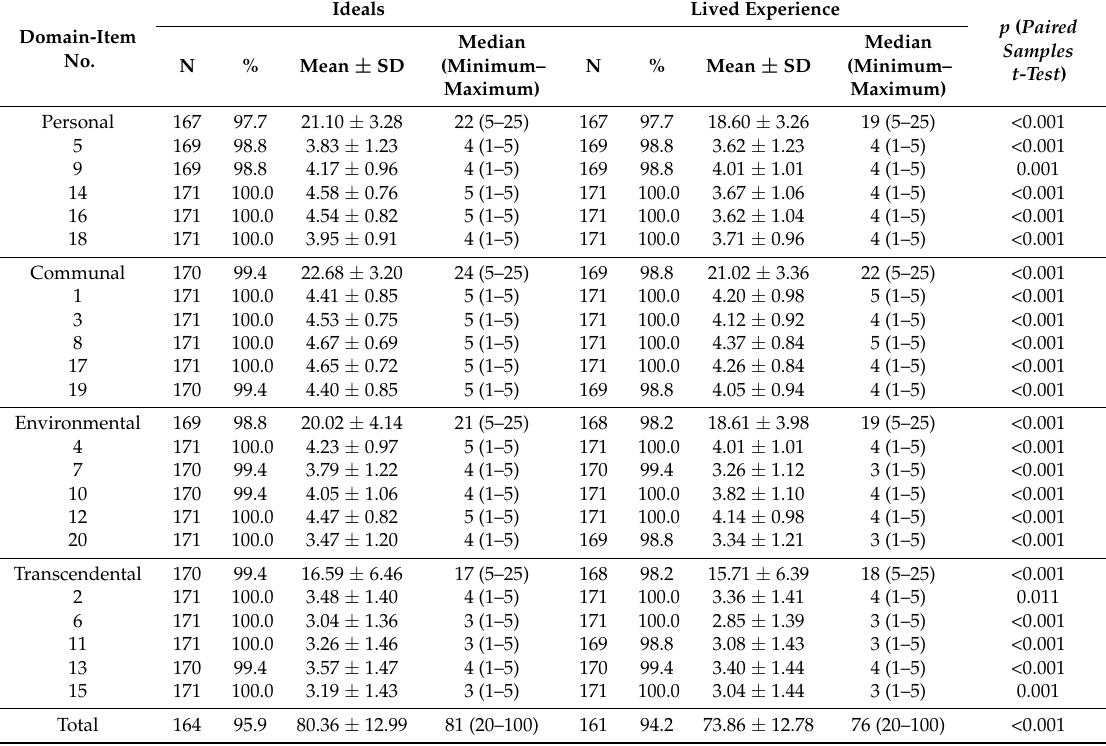
Table 4. Summary statistics for each item/domain of the Ideals and Lived Experience sections of